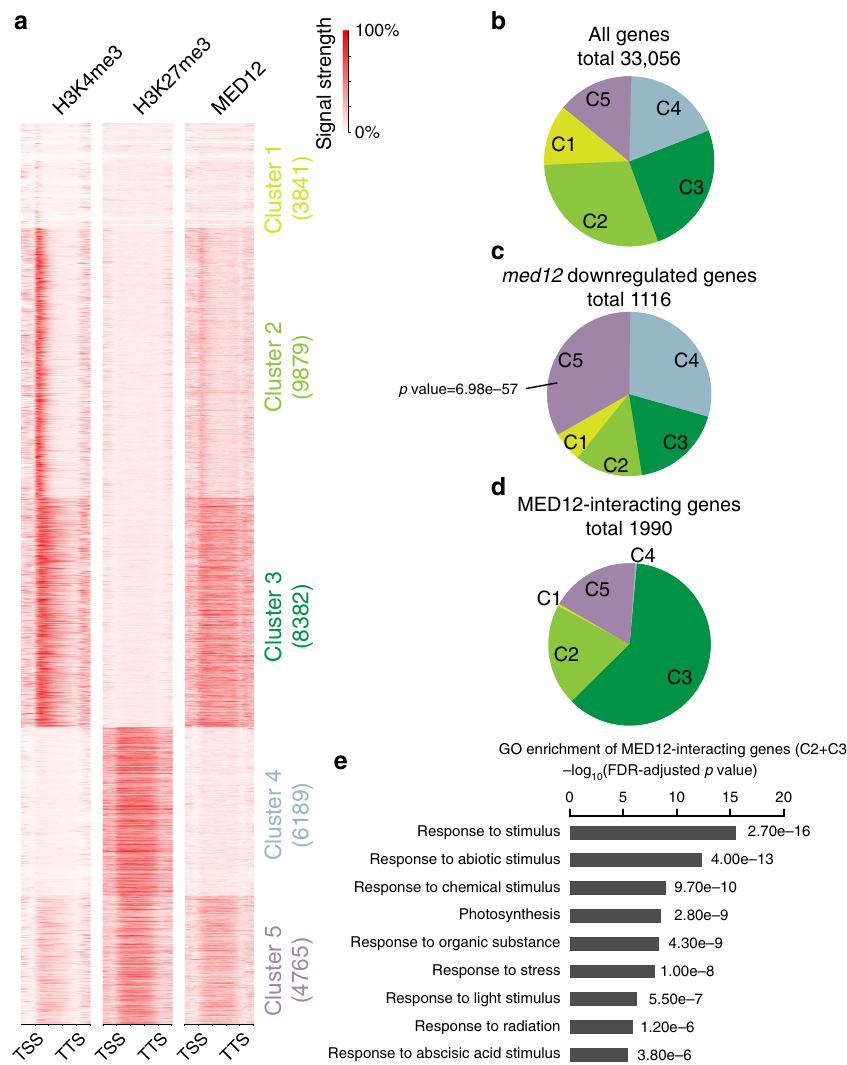
Fig. 6 Features of MED12-interacting genes. a Heatmap ordered based on k -means clustering of H3K4me3, H3K27me3, and MED12 ChIP-seq signals at all Arabidopsis genes (cluster n = 5). The number of genes from each cluster is labeled to the right. Color codes are shared with pie chart in b – d . b The percentage of genes derived from each of the fi ve clusters de fi ned in a . The percentage was calculated by dividing the number of genes from each cluster by the total number of Arabidopsis genes. c The percentage of med12 downregulated genes derived from each of the fi ve clusters de fi ned in a . The percentage was calculated by dividing the number of med12 downregulated genes from each cluster by the total number of med12 downregulated genes. p value indicates a statistical signi fi cance in the enrichment of med12 downregulated genes in Cluster 5 (hypergeometric test). d The percentage of MED12- interacting genes derived from each of the fi ve clusters de fi ned in a . Similarly calculated as in c , except for MED12-interacting genes. e Statistical signi fi cance of GO term analysis of MED12-interacting genes derived from Clusters 2 and 3 as de fi ned in a (Fisher ’ s exact test). Source data underlying b – e are provided as a Source data fi